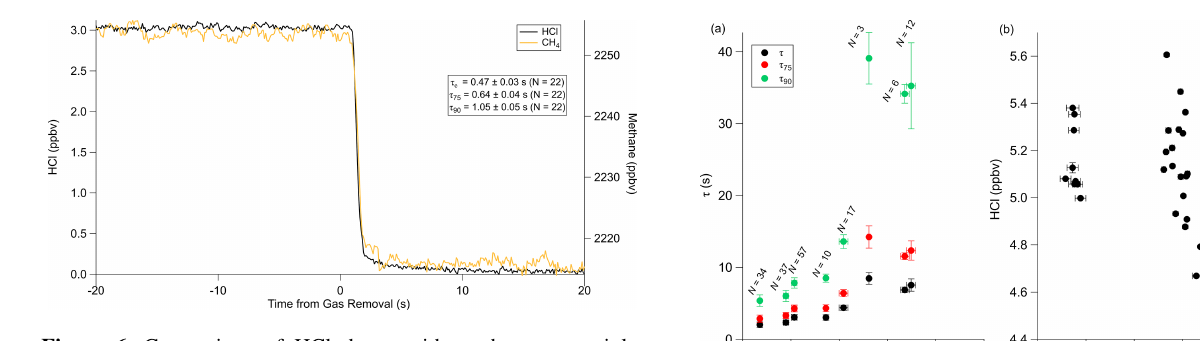
Figure 6. Comparison of HCl decay with methane at an inlet flow rate of 12.7Lmin − 1 . Note that the methane signal repre- sents the change in concentration from sampling a zero-air cylinder ( ∼ 2260ppbv) to sampling ambient air ( ∼ 2215ppbv).